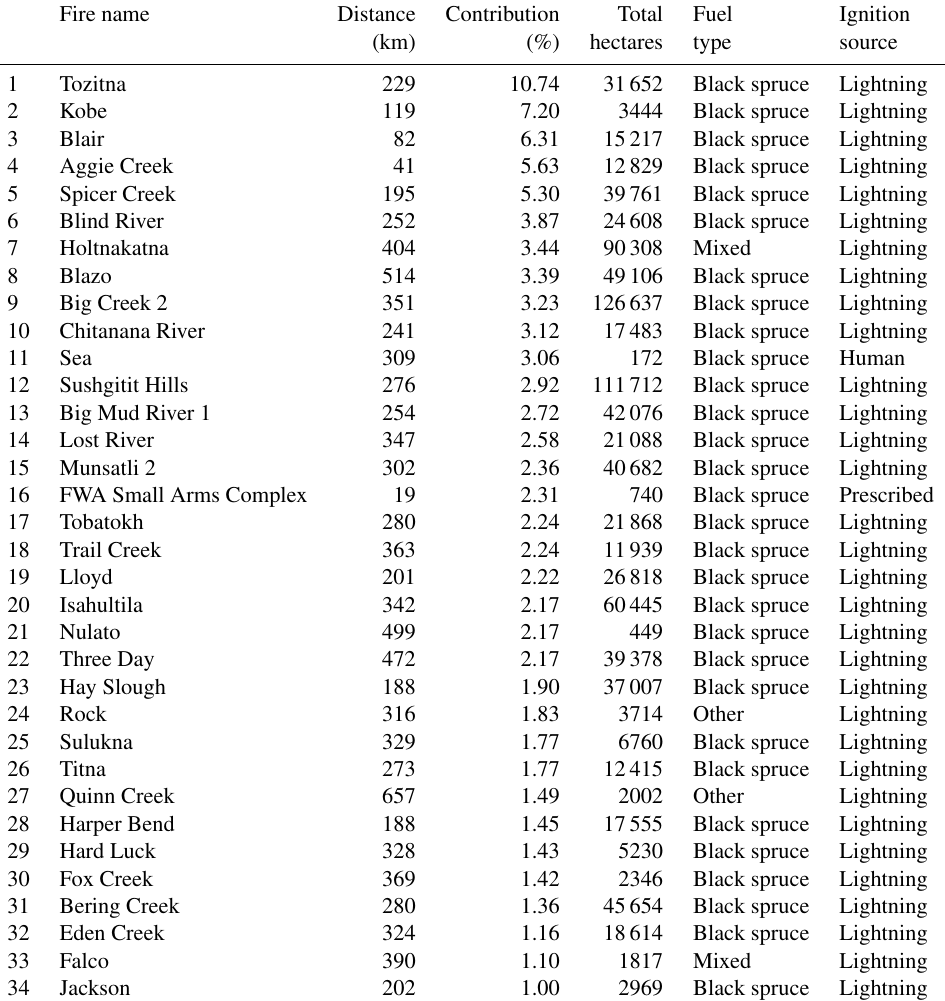
Table 3. All fires that contributed to at least 1% of the total CO anomaly observed at CRV, in order from largest CO contribution to smallest CO contribution. The distance column represents the distance of the center of the fire perimeter to CRV tower. “Contribution” is the percent contribution to the total integral of fire CO at CRV for the entire 2015 fire season. Some fires were grouped together if they were inside the same 0.5 ◦ grid cell during model coupling. For those cases, individual fire contribution to the CO anomaly observed at the CRV tower was weighted based on fire